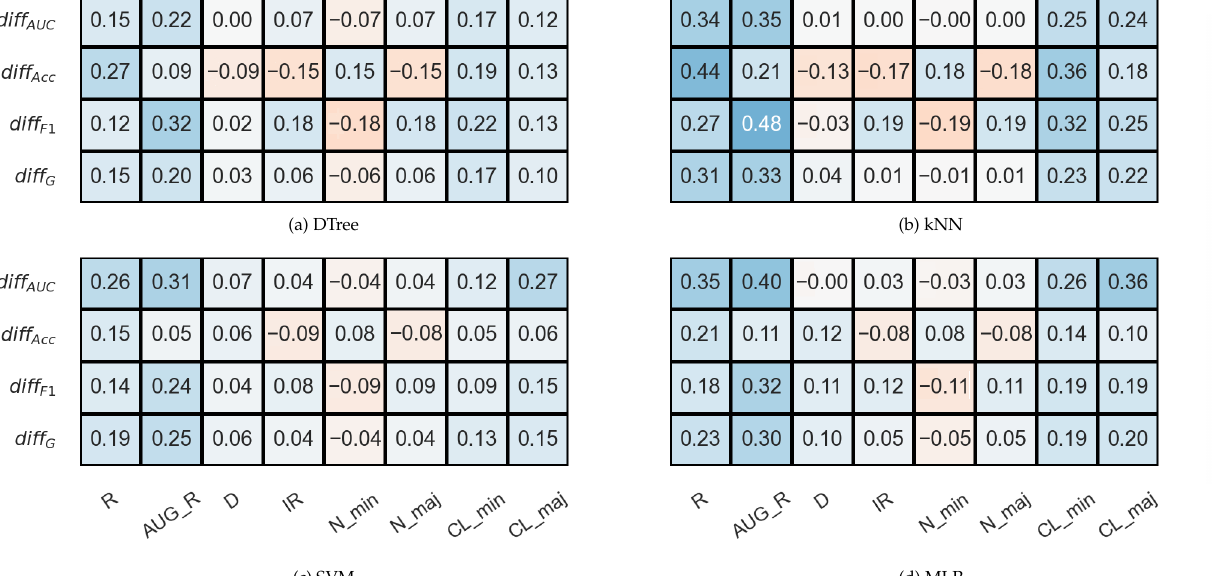
Figure 5. Result of the Spearman’s rank correlation test between some features of the synthetic data set and the relative differences between the DOB-SCV and SCV results of the classification combined with oversampling obtained on the data